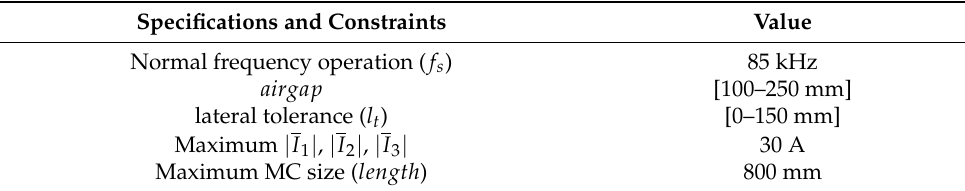
Table 1. System specifications and physical constraints.